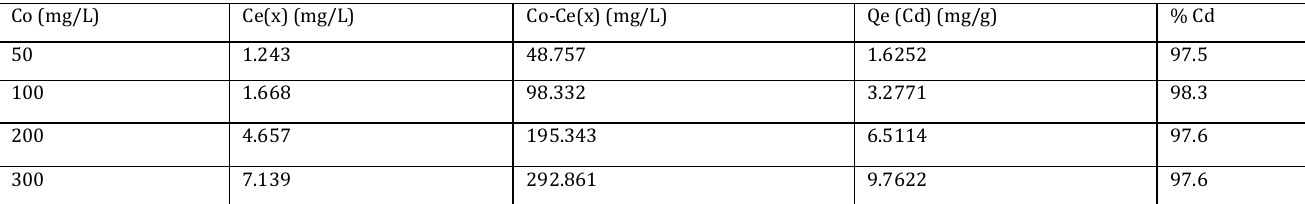
Table 7: Effect of concentration on the removal of cadmium from aqueous solution